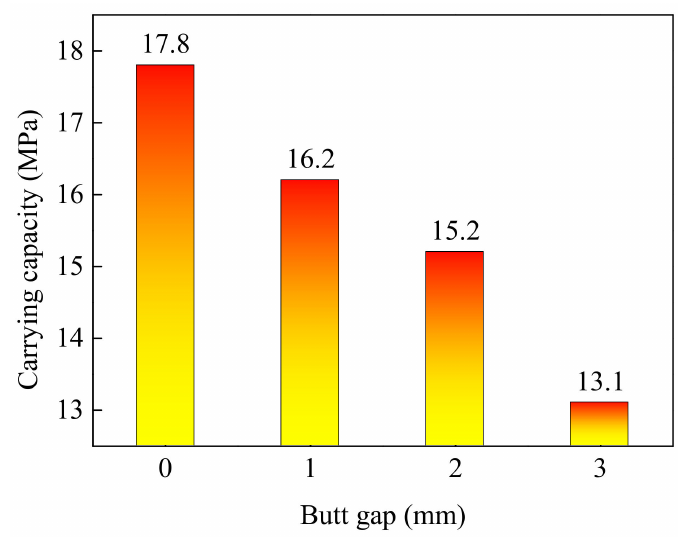
Figure 16. Carrying capability corresponding to different butt